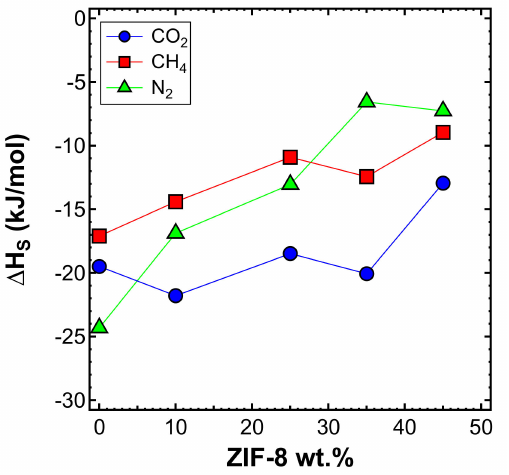
Figure 23. Heat of sorption estimated in the interval 35–65 ◦ C for three gases in the various mixed-matrix membranes inspected, as a function of filler loading. Table 7. Heat of sorption ∆ H S in the range of 35–65 ◦ C for ZIF-8 / PPO MMMs at di ff erent filler